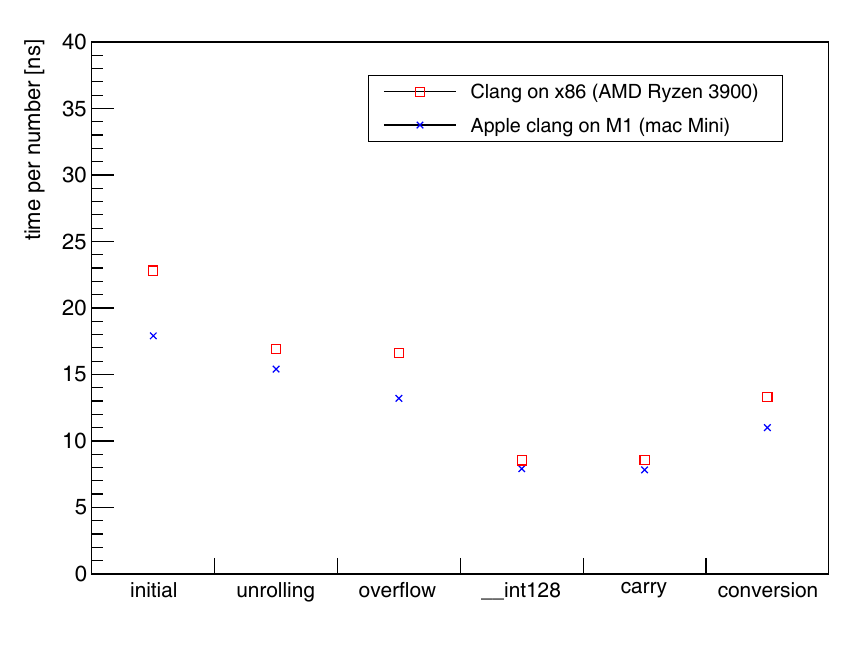
Figure 2. Performance results on Apple’s M1 processor compared to Clang on